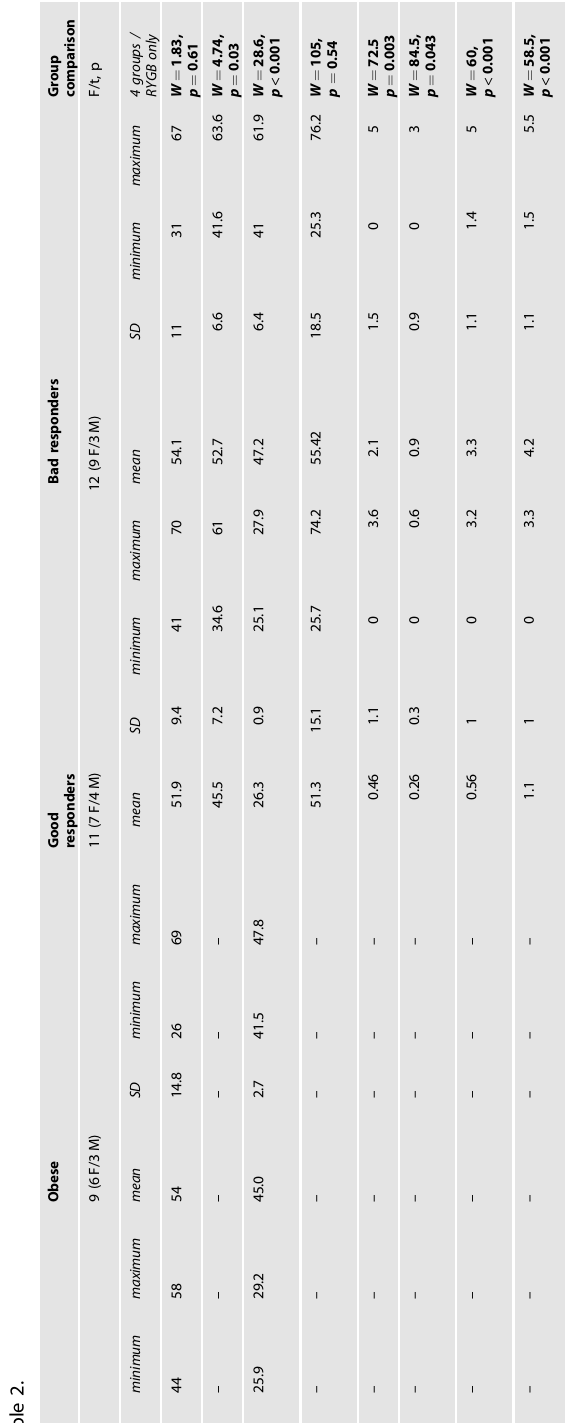
SCFA, similar results emerged, except for acetate: here, while the direct effect c ’ did not reach signi fi cance (ß = − 0.3, p = 0.13), higher Parabacteroides abundance was linked with higher post- prandial hunger ratings through higher fecal acetate levels Supplementary Table 4). Exploratory analysis based on reviewer suggestions showed that, when adjusting the correlational analysis for body fat mass, associations with inversely health-related bacterial genera remained largely signi fi cant (TFEQ and Clostridum XIVb , Collinsella , Fusicatenibacter , Parabacteroides , all p < 0.05), yet positively health- related correlations do not (only for hunger ratings with Clostridium XVIII and Roseburia , all p < 0.05) (relating to Fig. 2, for details see SI Table 5). For fi ber intake associations, only the negative association with Collinsella abundance and TFEQ disin- hibition scores remain signi fi cant (relating to Fig. 3, for details see SI Table 5). The association between propionate levels in feces and TFEQ cognitive restraint when adjusted for body fat mass is no longer signi fi cant (relating to Fig. 4). Microbiota genera differences between overweight, obese, and surgery groups In sample 2, we aimed to con fi rm links between the genera of interest from sample 1 and treatment success and eating T a